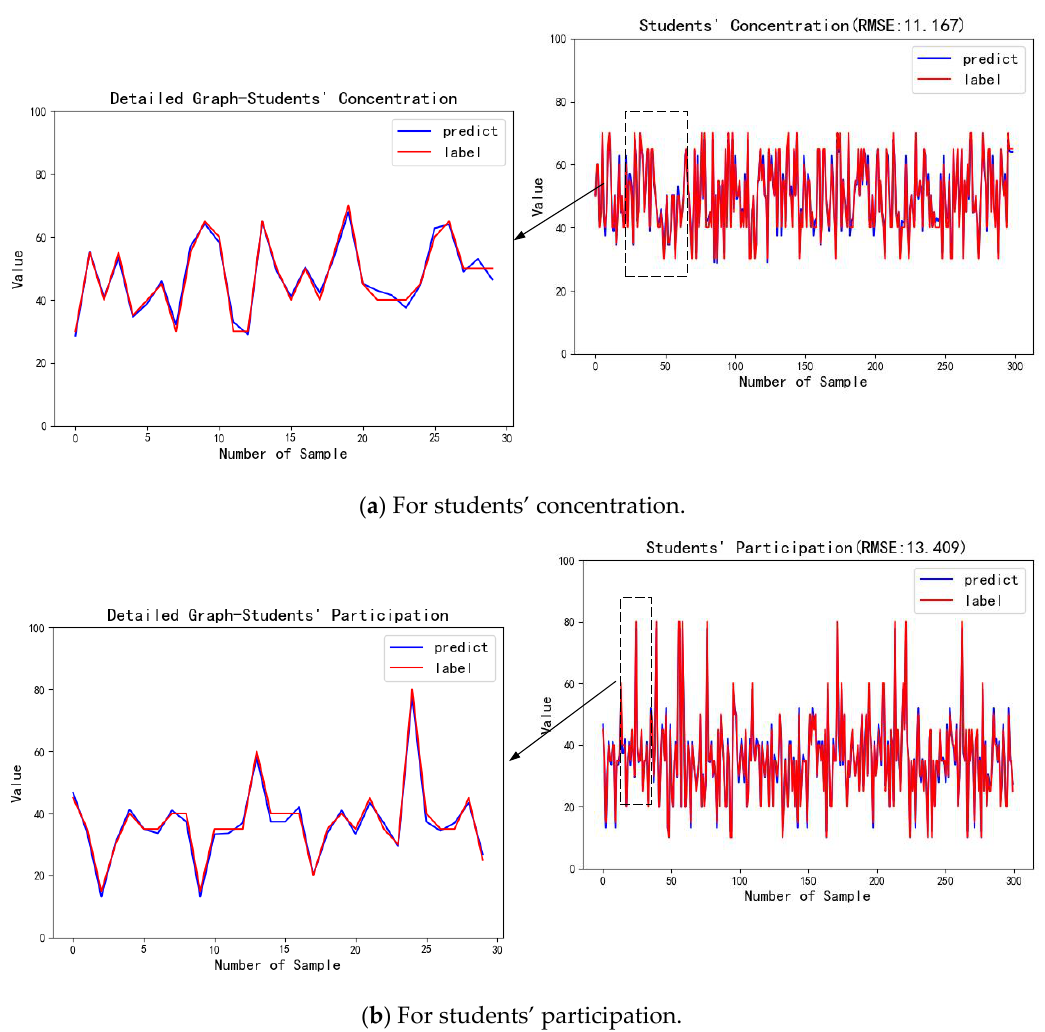
Figure 9. Performance analysis for score indicators evaluated by the statistical modeling module.